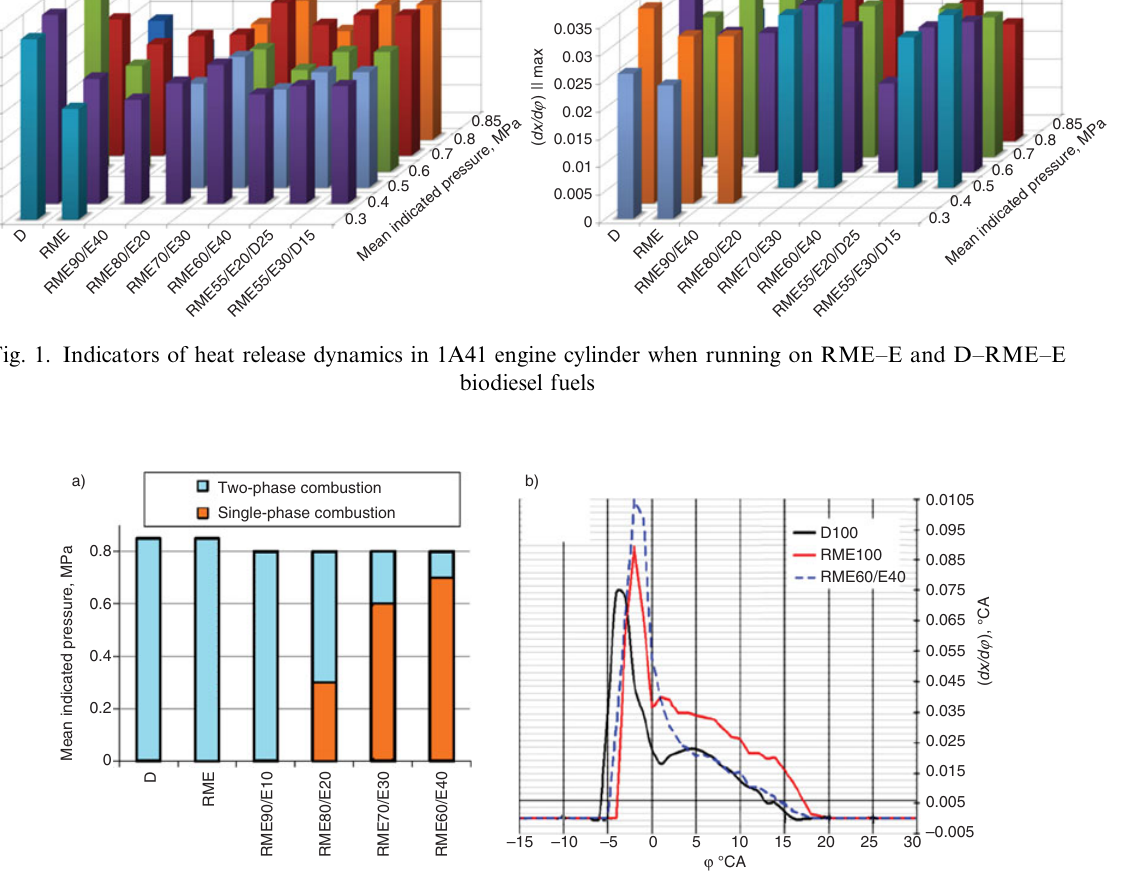
Fig. 2. Dynamics of heat release characteristic dx / d 8 with increase of E alcohol